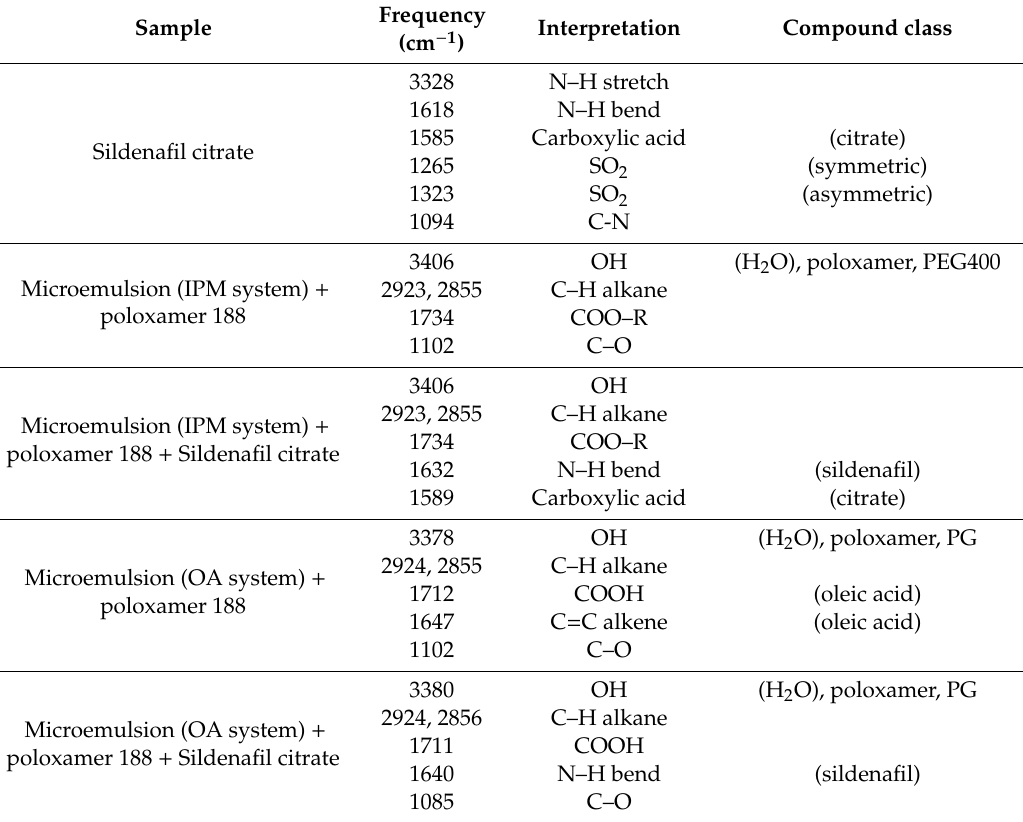
Figure 4. The FTIR spectra of sildenafil citrate, the microemulsion-loaded hydrogels, and the sildenafil microemulsion-loaded hydrogel over the region of 400–4000 cm −1 . Table 5. Interpretation of the functional group and wave number by FTIR